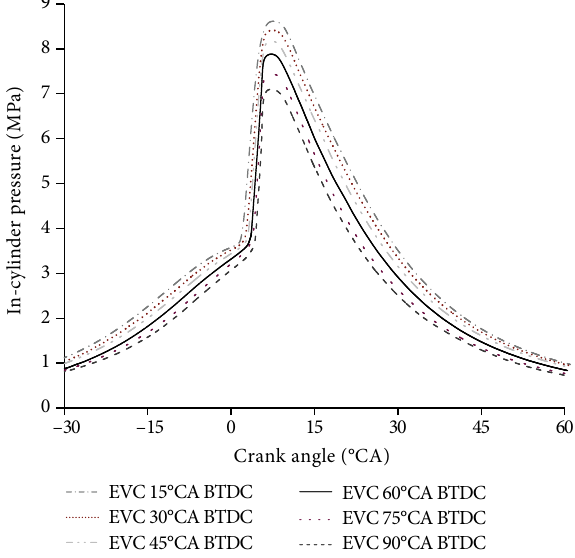
Figure 5: In fl uence of advanced degree of EVC timing on EGR rate.